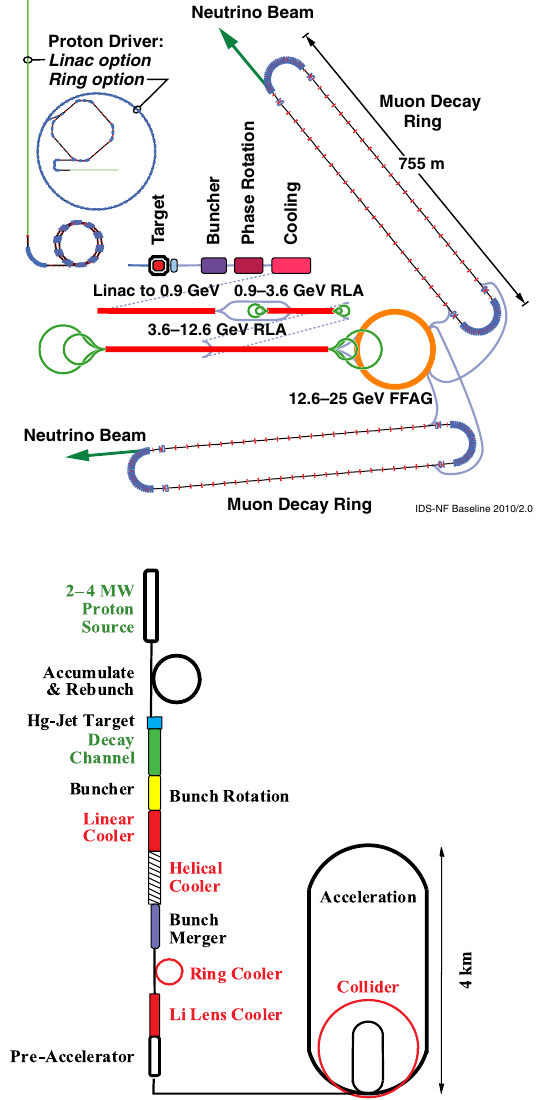
FIG. 1. Schematic of a 25-GeV NF (top); schematic of a 1.5-TeV MC